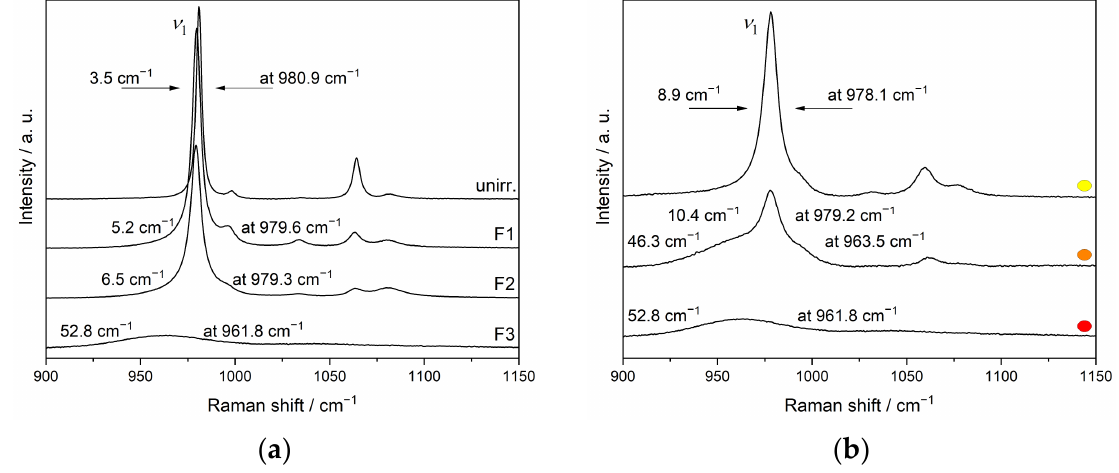
Figure 11. Raman spectra depicting the region of the stretching vibrations in unirradiated and Au ion irradiated FIB lamellae prepared from monazite-structured SmPO 4 , showing the broadening and shift of the symmetrical stretching vibration ν 1 with increasing fluence from F1 to F3 (( a ); cf., Figure 9), and for variable crystalline regions in the lamella irradiated at fluence F3 (( b ), cf., Figure 10) (Figs. reproduced from